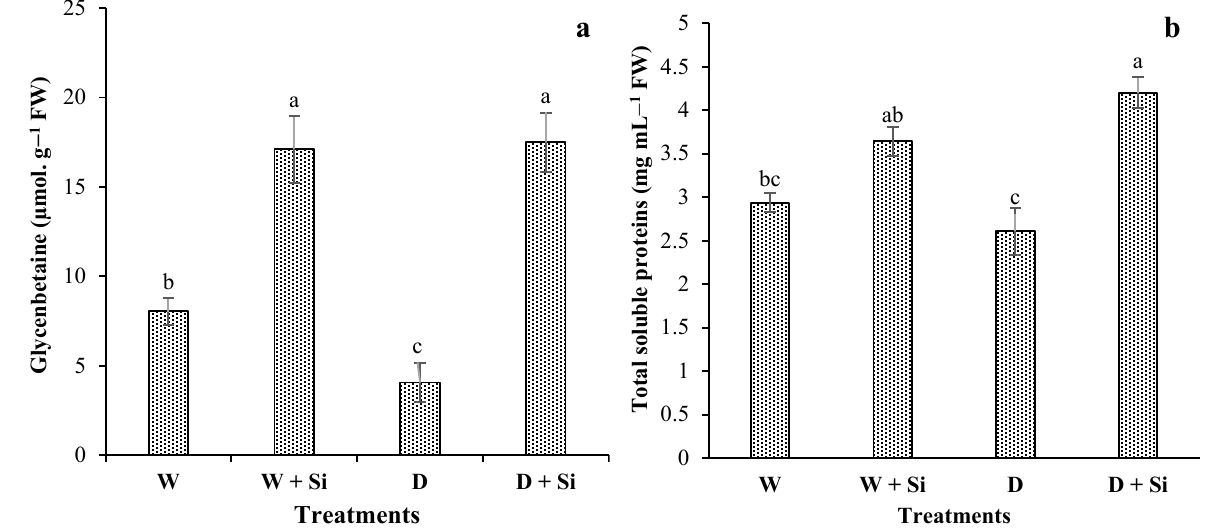
Figure 4. Effect of foliar Si supplementation on glycinebetaine ( a ) and total soluble proteins ( b ) of Gerbera jamesonii under water-deficient conditions. Each bar shows a mean of four replicates ± SE. Dissimilar lettering illustrates significant statistical differences at p ≤ 0.05 after applying LSD test.